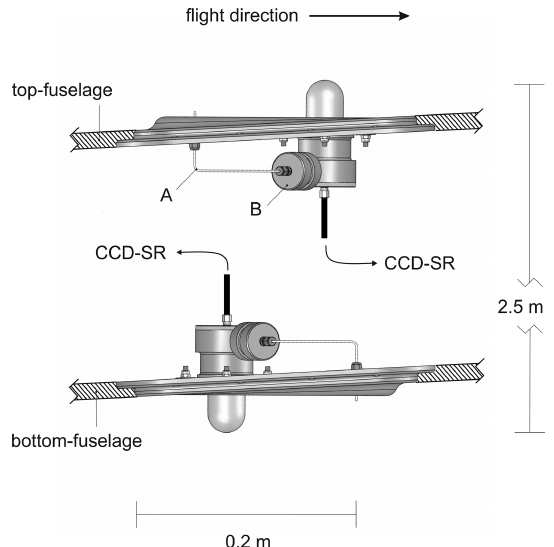
Figure 2. Scheme of the 4 π actinic radiation setup on HALO, com- posed of two 2 π receivers. The tilts in the instrument flanges com- pensate for a typical in-flight pitch angle of HALO. Receiver hous- ings are pressure balanced via 1 / 16in. capillaries (A) connected through cartridges with a drying agent mounted at the housing sides